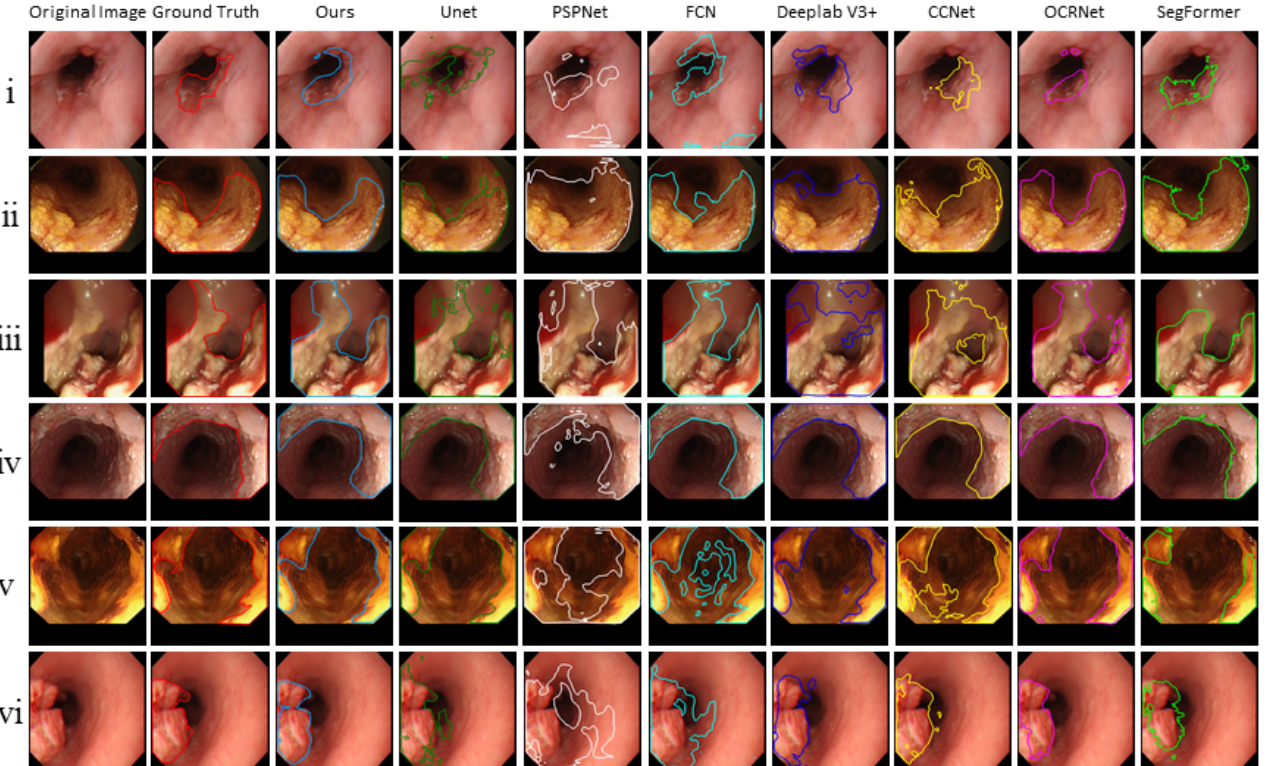
Figure 5. The segmentation results of the proposed model and other models.